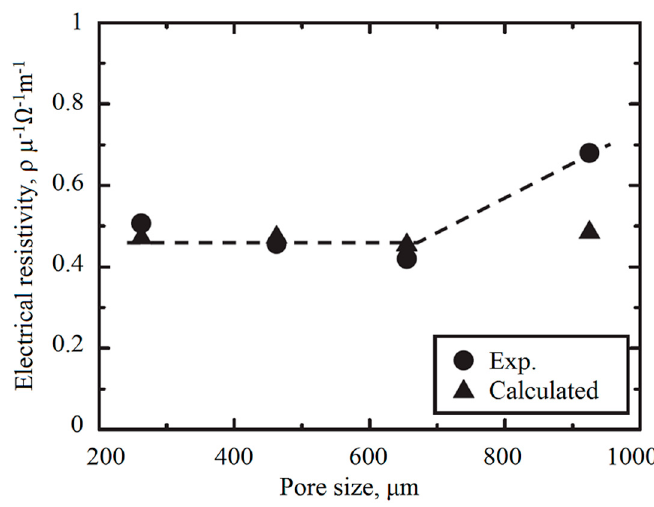
Figure 2. Effect of pore size on the electrical conductivity of porous aluminium with 80% porosity [36]